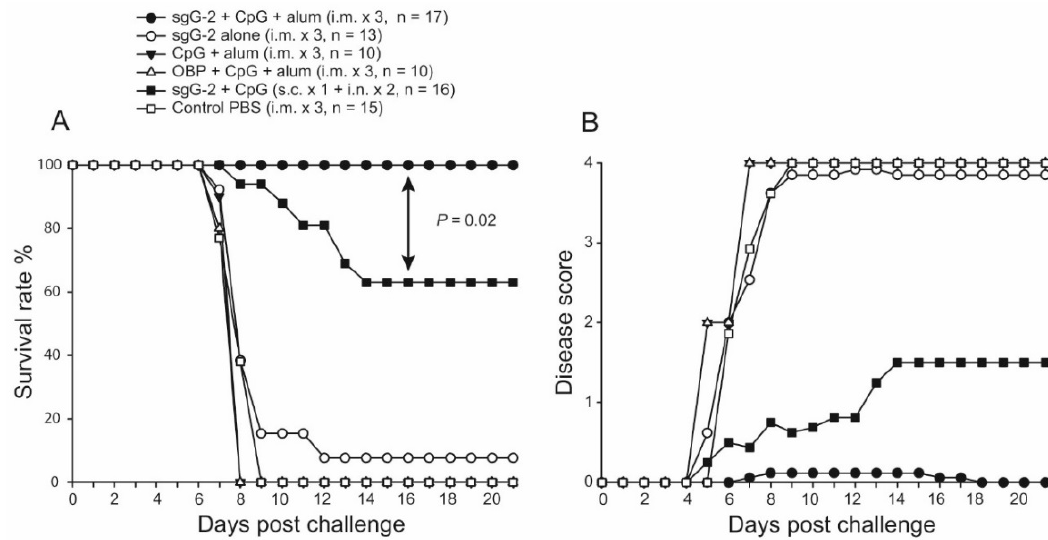
Figure 2. sgG ‐ 2 + adjuvant intra ‐ muscularly (i.m.) immunized mice all survived HSV ‐ 2 challenge with minimal disease. Mice were immunized three times i.m. with sgG ‐ 2 with, and without CpG and alum, with CpG and alum alone, with origin binding protein (OBP) of HSV ‐ 1 and CpG and alum, or with phosphate buffered saline (PBS). Mice were also immunized with sgG ‐ 2 combined with CpG, once subcutaneously followed by two intranasal administrations. Mice were challenged with 25 × LD 50 of HSV ‐ 2 333 (10 5 PFU) intra ‐ vaginally (day 0). ( A ) The survival rate; and ( B ) disease score were followed for 21 days post challenge. Data are shown from two separate experiments except for PBS vaccinated control groups which were pooled from three experiments.